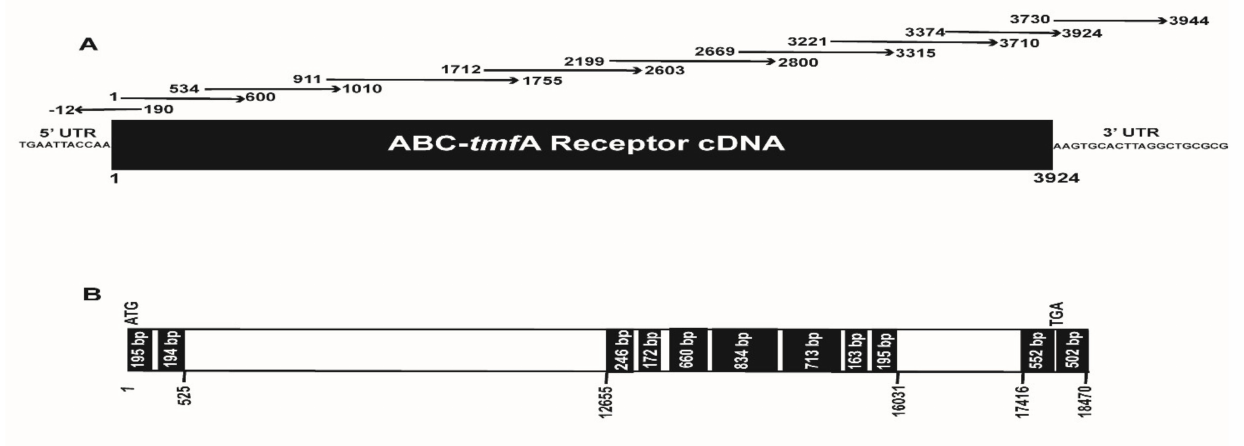
Figure 2. ( A ) Aea ABC- tmf A receptor cDNA map and sequencing strategy. Arrows show the size of the amplicons that were amplified by PCR, cloned and sequenced. The over lapping amplicons allowed a reliable assembly of the cDNA. The cDNA is 3924 bp long and the 5 (cid:48) and 3 (cid:48) UTRs are also shown. ( B ) A map of the ABC-tmf A-importer gene showing 11 exons (black color) and 10 introns (white color). The gene is 18,470 bp long starting at the ATG and with 502 bp past the TGA stop